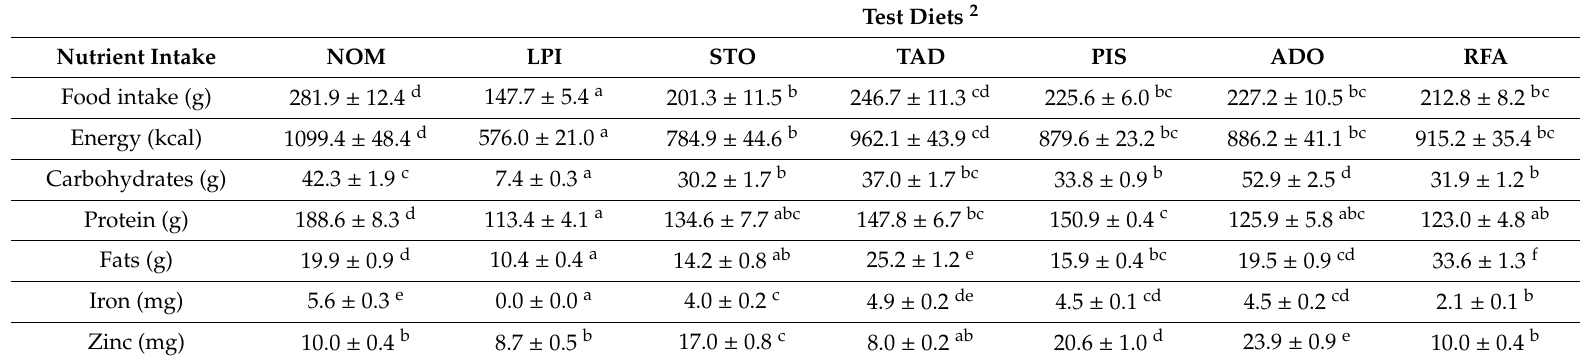
Table 3. Food and nutrient intake of rats during the 14 day repletion period